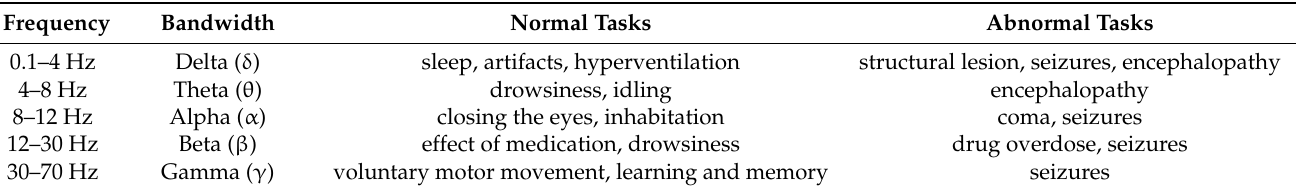
Table 1. The frequency bands of EEG signals